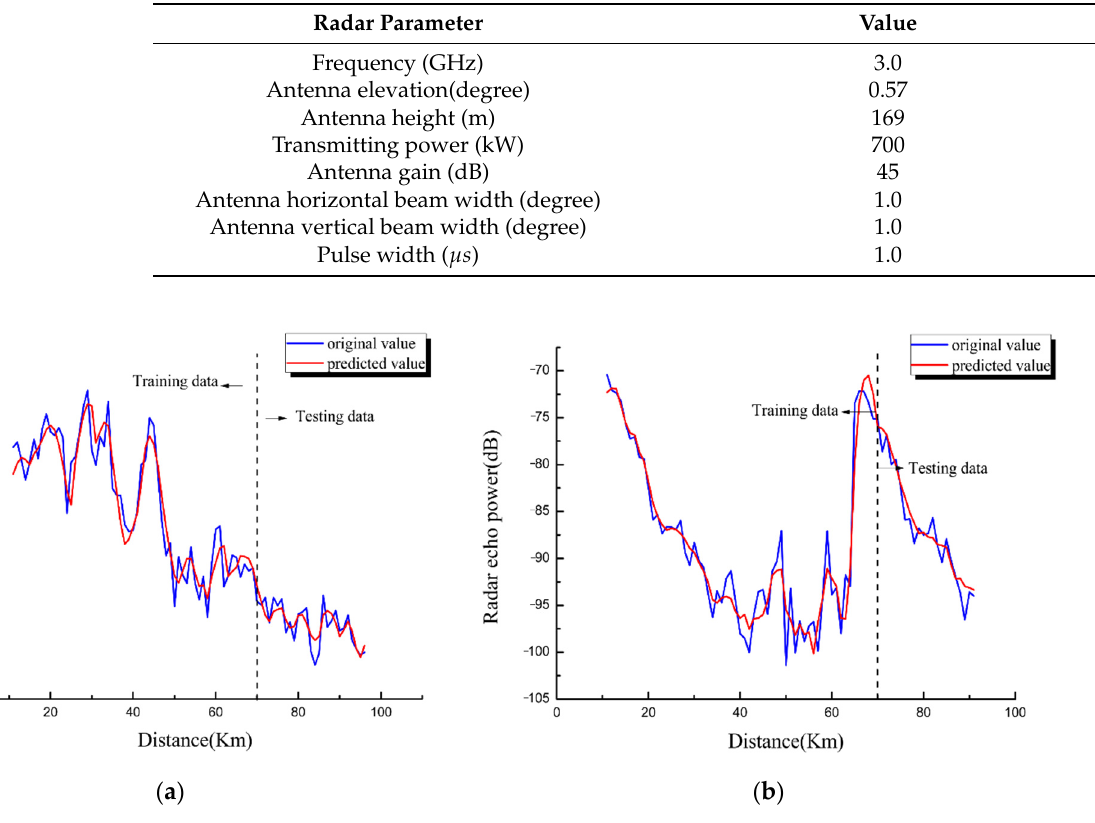
Table 12. Doppler weather radar parameters.